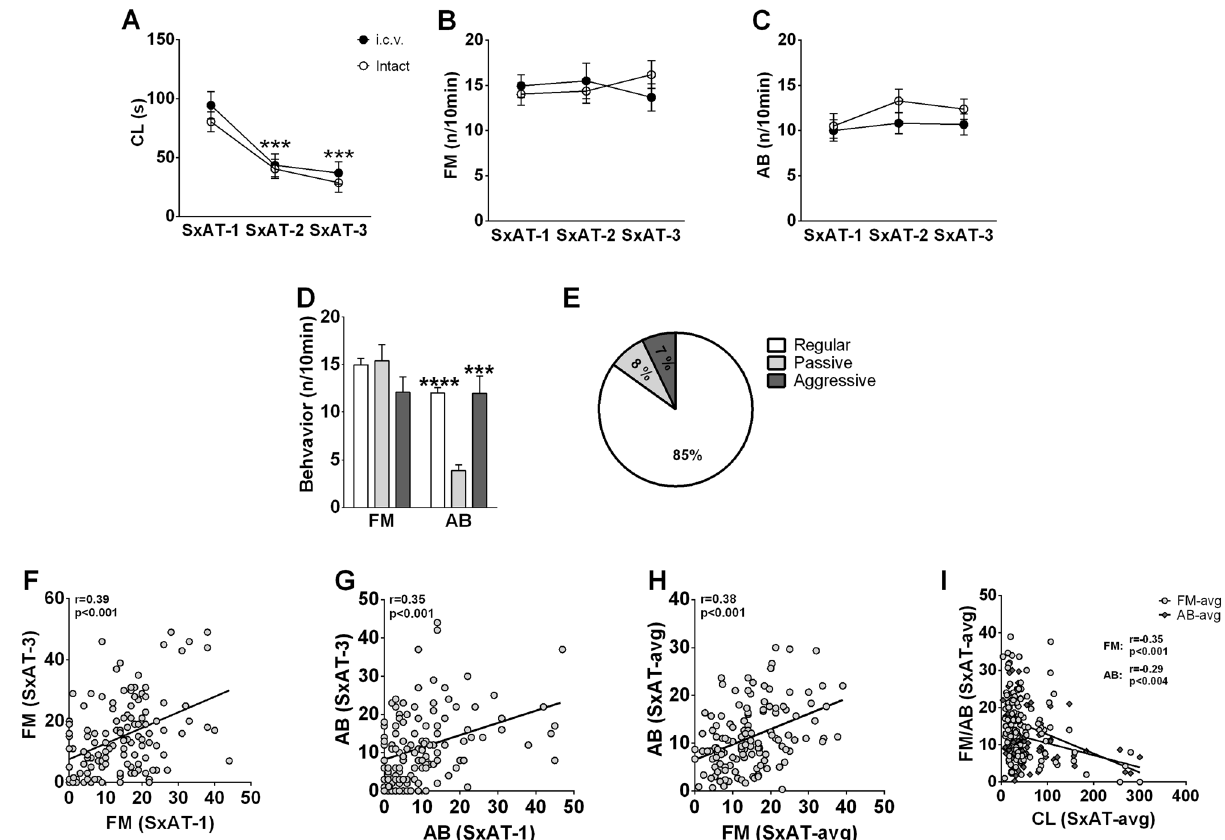
Fig. 1 Behavioral pro fi le of adult male Wistar rats in sexual aggression tests (SxAT). A Latencies to copulate (CL) with a receptive female, ( B ) frequency of forced mounts (FM), and ( C ) frequency of aggressive behavior (AB) of intact (white circles n = 69) and i.c.v. cannulated (black circles, n = 57) males toward a non-receptive female during the SxAT performed on 3 consecutive days. D Frequency of forced mounts (FM) and aggressive behavior (AB) of males against females with a regular, a passive, or an aggressive response type (all three SxATs combined). All data are means ± S.E.M. E Percentage of trials where males ecountered females displaying regular, passive or aggressive responses to the male forced mounts n = 378. F Scatter plot of FM frequencies displayed during SxAT-1 vs. SxAT-3. G Scatter plot of AB frequencies during SxAT-1 vs. SxAT-3. H Scatter plot of FM frequencies (averaged over SxAT-1, SxAT-2 and SxAT-3) vs. AB frequencies (averaged over SxAT-1, SxAT-2 and SxAT-3). I scatter plots of the CL vs. FM (dark-gray diamonds) or AB (gray circles) averaged over SxAT-1, SxAT-2 and